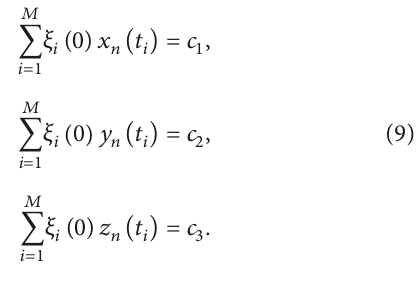
𝑀 (𝑡 − 𝑡 ) is center of gravity Lagrange and 𝜔 𝑗 = 1/∏ 𝑖 𝑗 𝑖=1,𝑗 ̸=𝑘 interpolation weight. The vector